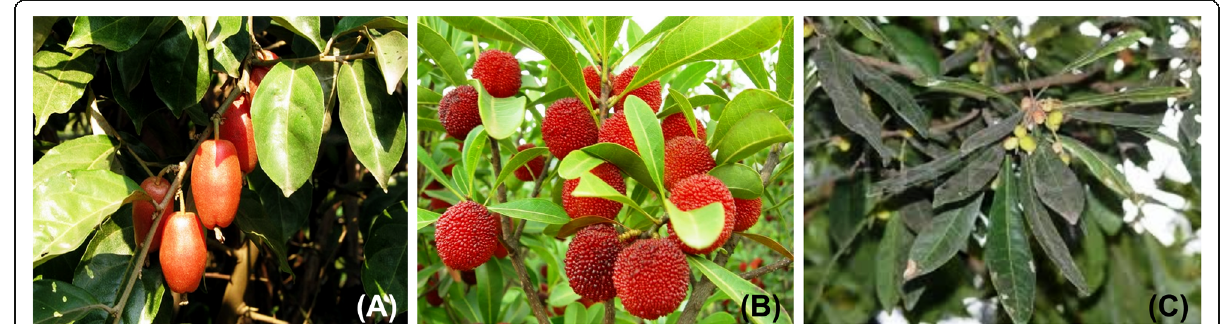
Fig. 1 Plants bearing fruits of a Elaeagnus pyriformis , b Myrica nagi , c Myrica